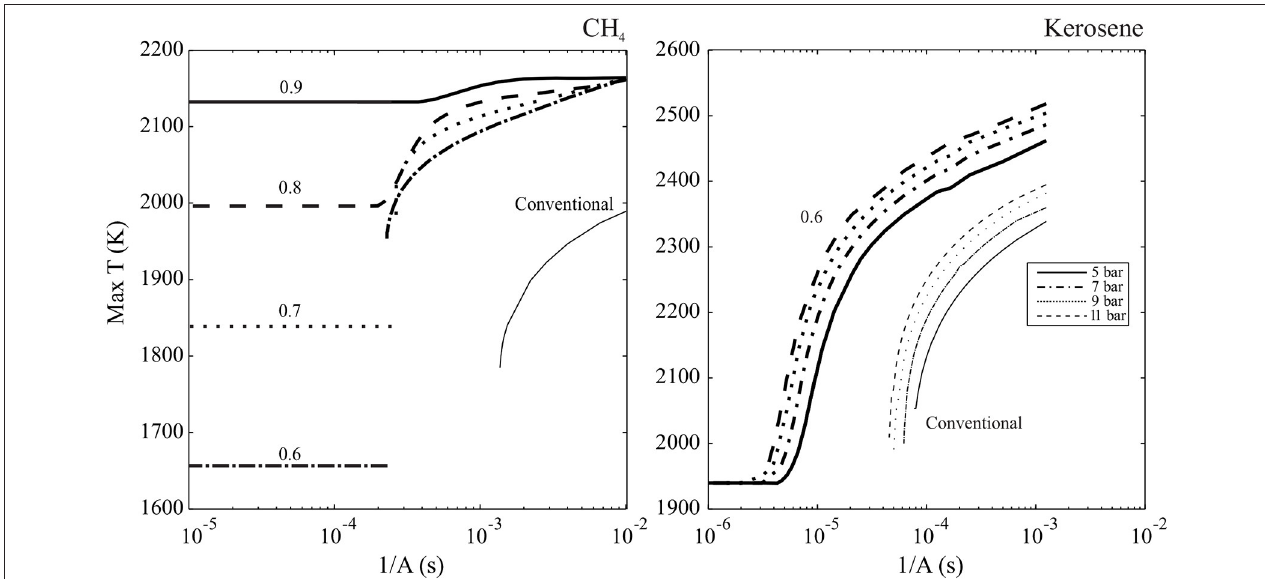
FIGURE 4 | Maximum temperature of methane (Left) and kerosene (Right) counterflow MILD (bold, marked with equivalence ratio of hot combustion product oxidiser) and conventional flames varying with strain rate, A , from Sidey et al. (2016) and Sidey and Mastorakos (2015).